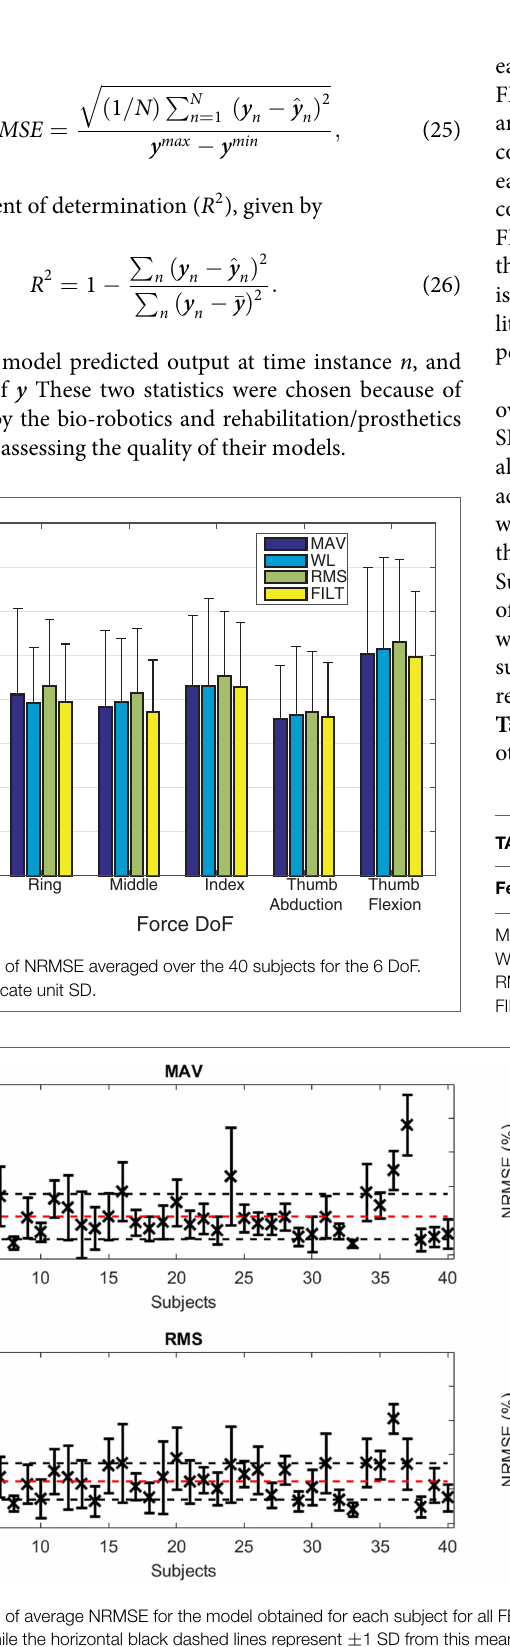
Frontiers in Bioengineering and Biotechnology |